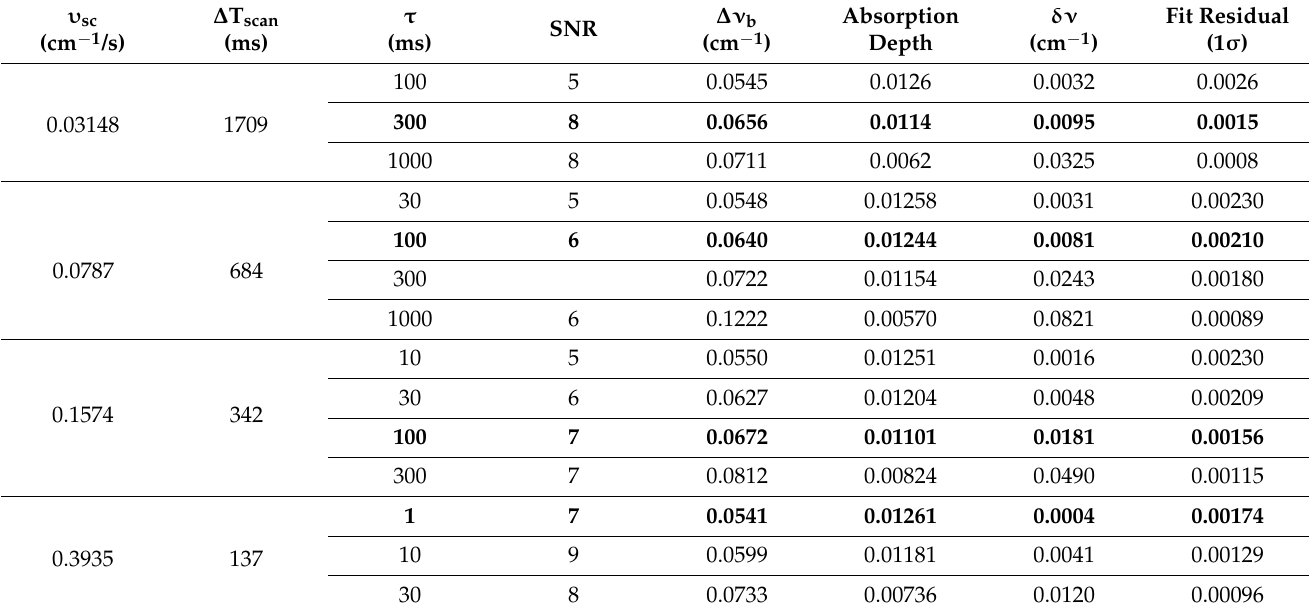
Table 3. Analysis of BB-based heterodyne spectra of CH 4 absorption at different scanning speeds of the LO frequency ( υ sc ) (i.e., different given scanning time ∆ T scan ) with different time constants ( τ ). 1 σ : Standard